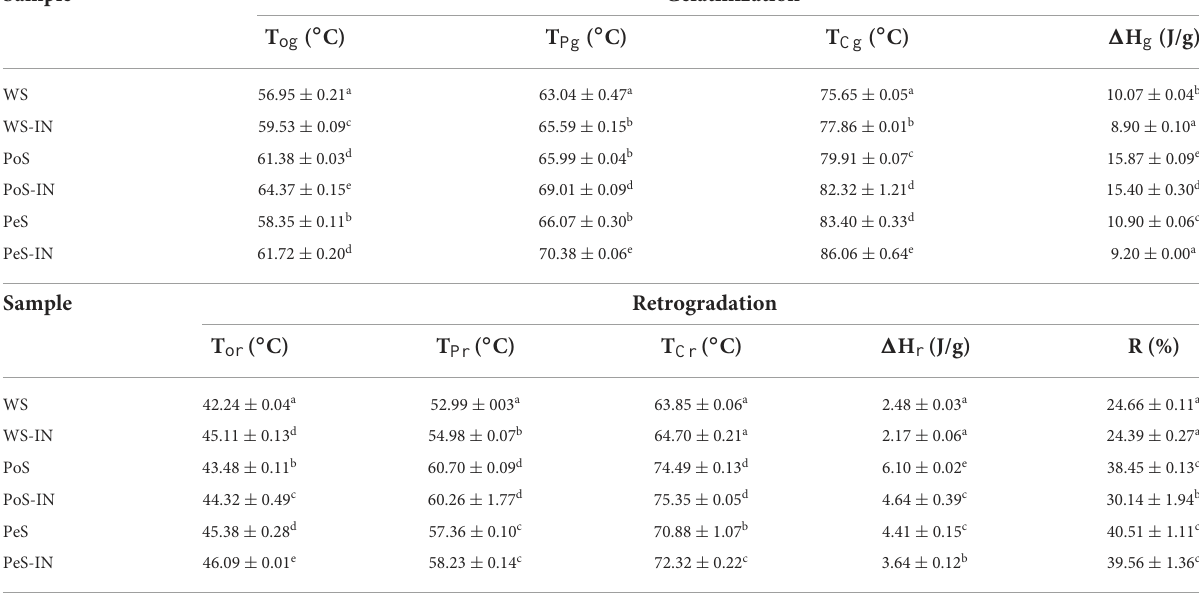
TABLE 2 Thermodynamic characteristics of gelatinization and retrogradation of inulin-different crystalline starch compound systems.